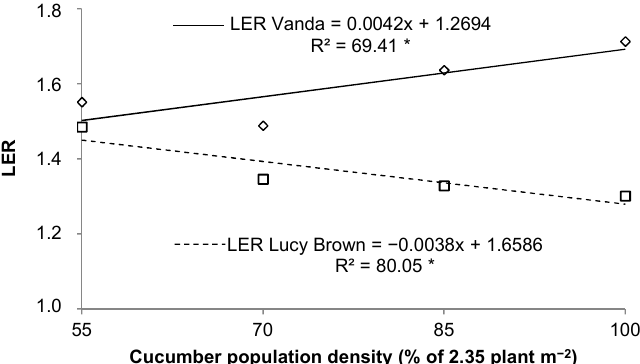
Figure 7. Land equivalent ratio (LER) of the intercropping of ‘Vanda’ and ‘Lucy Brown’ with cucumber. ♦ LER ‘Vanda’; (cid:3) LER ‘Lucy Brown’. * p ≤ 0.05 in F